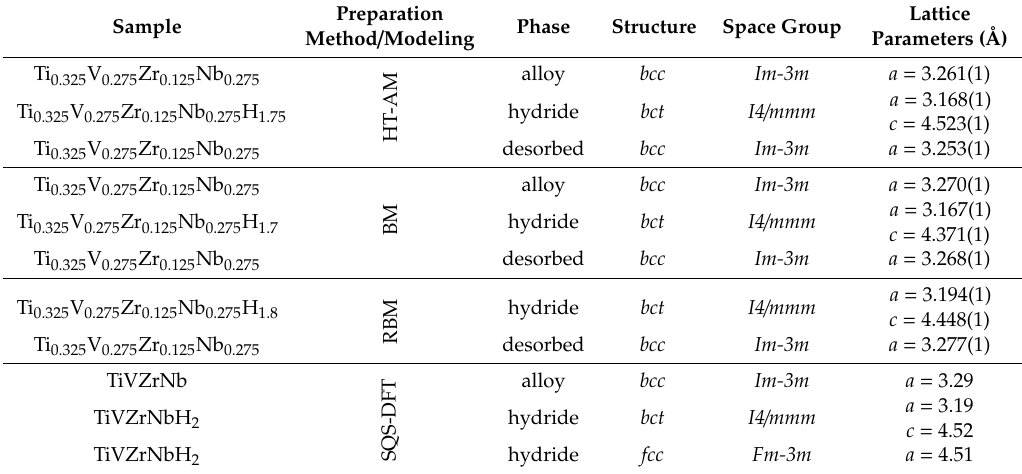
Table 1. Synthesis details and structural data for Ti 0.325 V 0.275 Zr 0.125 Nb 0.275 alloy and related